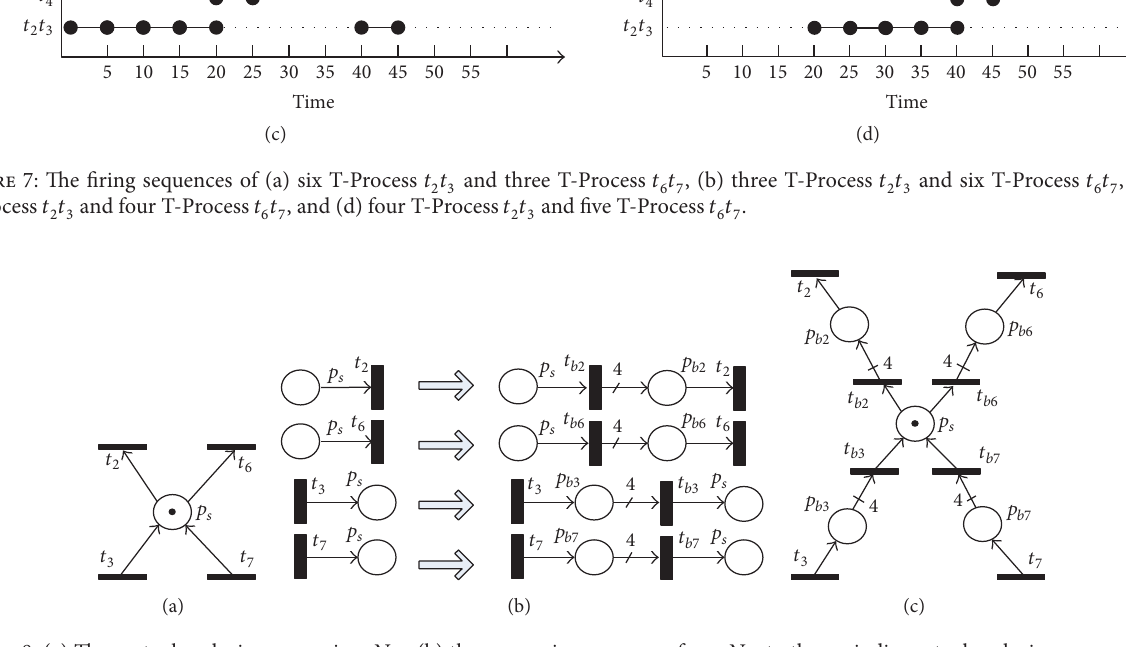
Figure 8: (a) The mutual exclusion supervisor 𝑁 𝑀 , (b) the conversion processes from 𝑁 𝑀 to the periodic mutual exclusion supervisor 𝑁 𝑆 , and (c) the converted periodic mutual exclusion supervisor 𝑁 𝑆